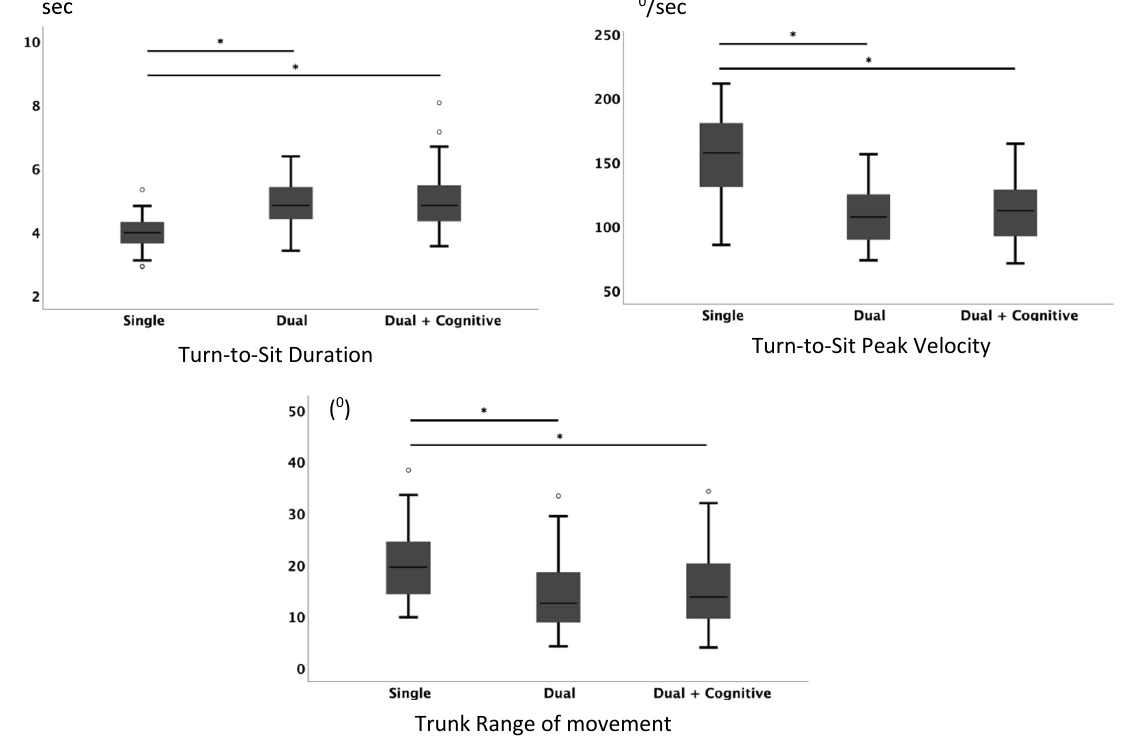
Figure 6. Turn-to-sit parameters for the three conditions: single task, dual task, and dual and cognitive task during the ITUG test. * Significant differences for pairwise